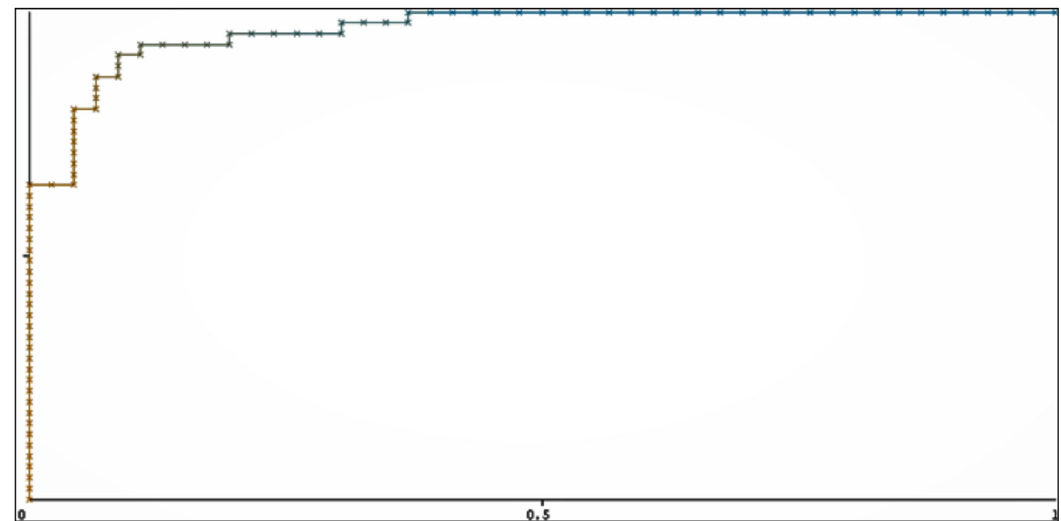
Fig. 8 The individual class-wise ROC plot for the proposed soft voting ensemble model showing the classi fi cation performance for class ‘ Med ’ .